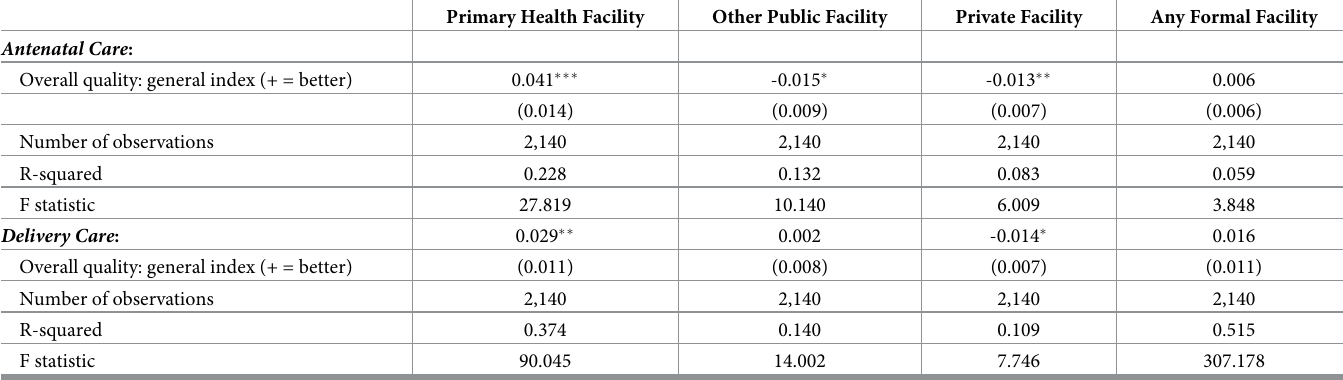
women’s survey. Neonatal, obstetric, and maternal outcomes are given as rates relative to the number of deliveries at the facility during the 12 months preceding the survey. The correlations between the overall index, the domain indices, the sub-domain indices and the indicators are shown in the Appendix, S1 File. For ease of interpretation, we standardize each index. Does facility quality influence utilization of obstetric care?. Table 3 relates overall qual- ity of care to utilization of antenatal and delivery care. In the first column, we examine how overall quality in a primary health facility relates to utilization of antenatal and delivery care in that facility. If higher quality is associated with greater utilization, a secondary question of interest is whether this might be because women are substituting from other health facilities or Table 3. Care quality and the utilization of obstetric